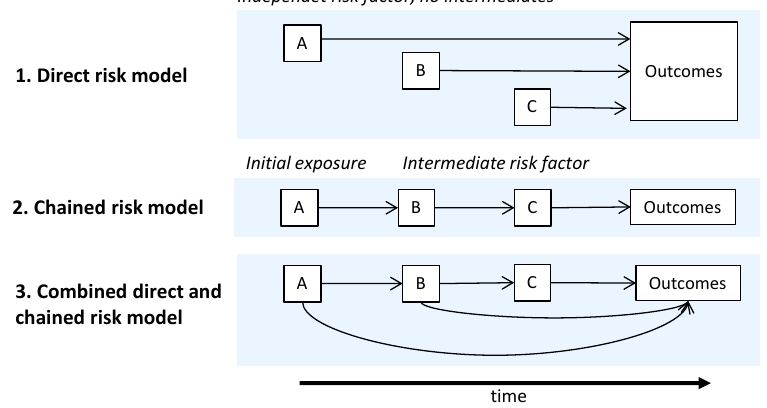
Figure 1. Causal models for disease etiology describing interactions between risk factors and the outcomes (modified from [5]). The outcomes can be immediate, or occur later in the life. A, B, C as generic placeholders for risk factors and outcomes in the causal models.